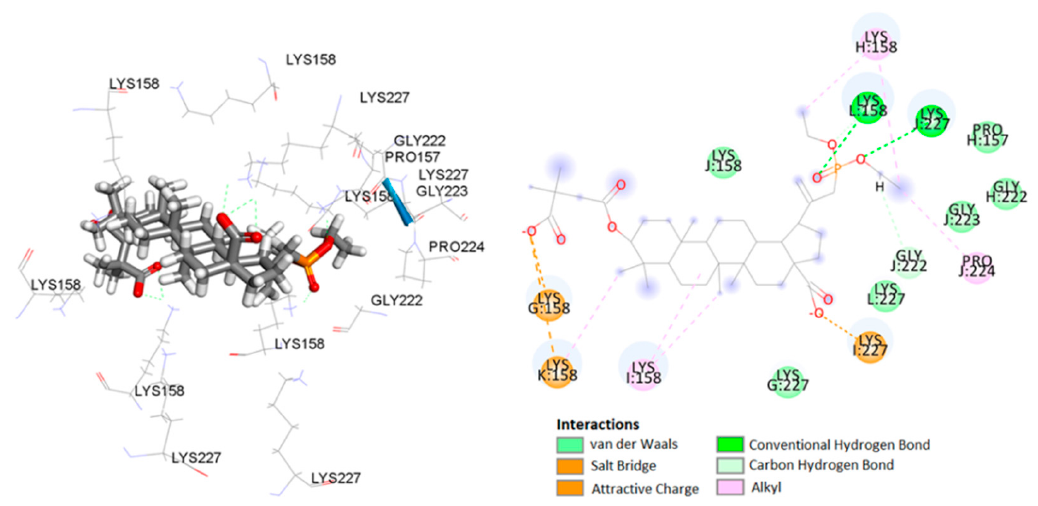
Figure 7. Predicted binding model of 14a with the HIV-1 CA CTD-SP1 protein.